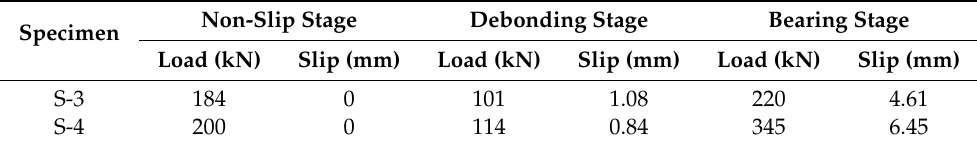
Table 3. Characteristic load and slip of the three stages of specimens